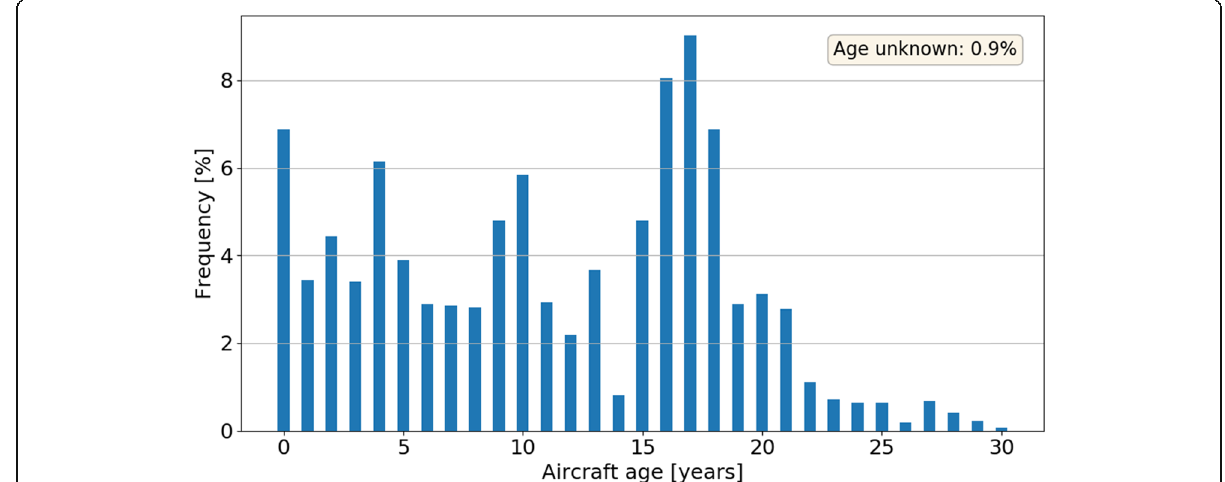
Fig. 5 Age distribution of the aircraft operated at Heathrow Airport on 11 June and 13 June 2018